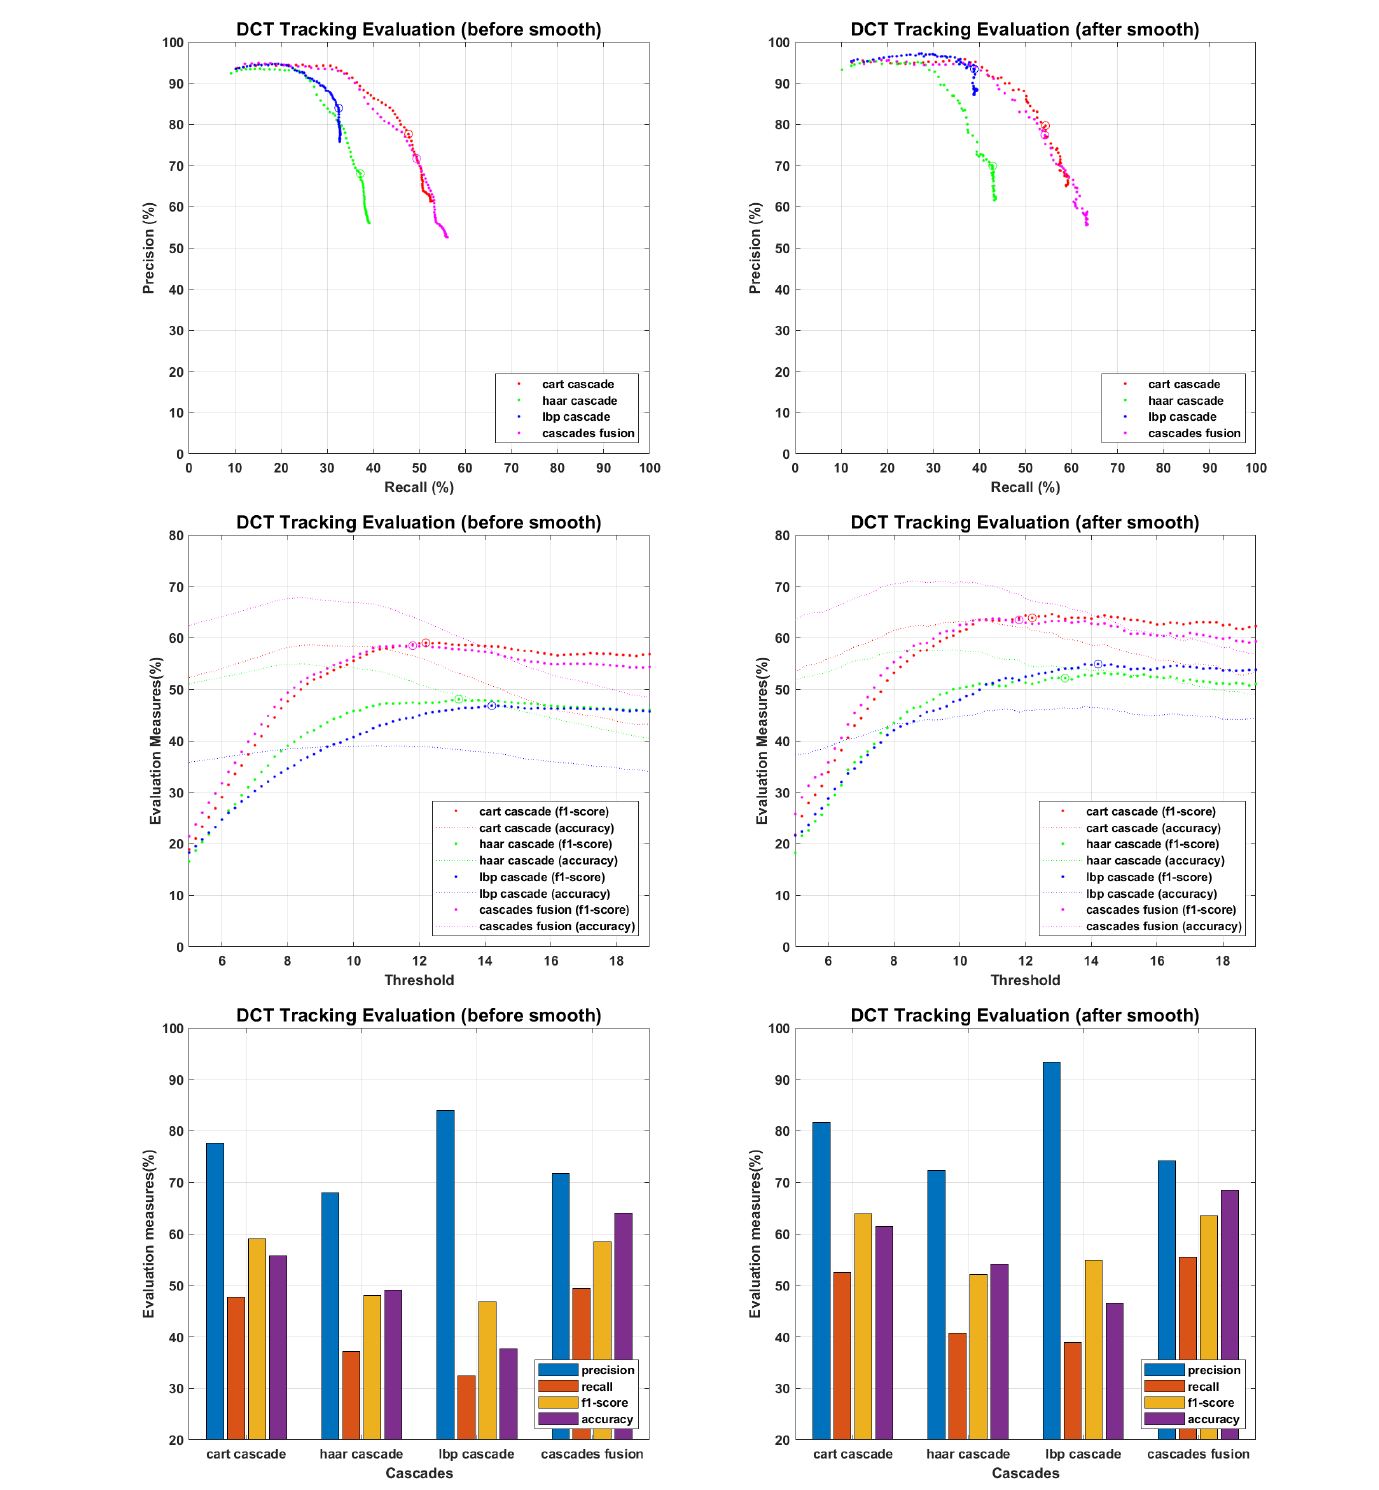
Figure 16. Tracking Evaluation for